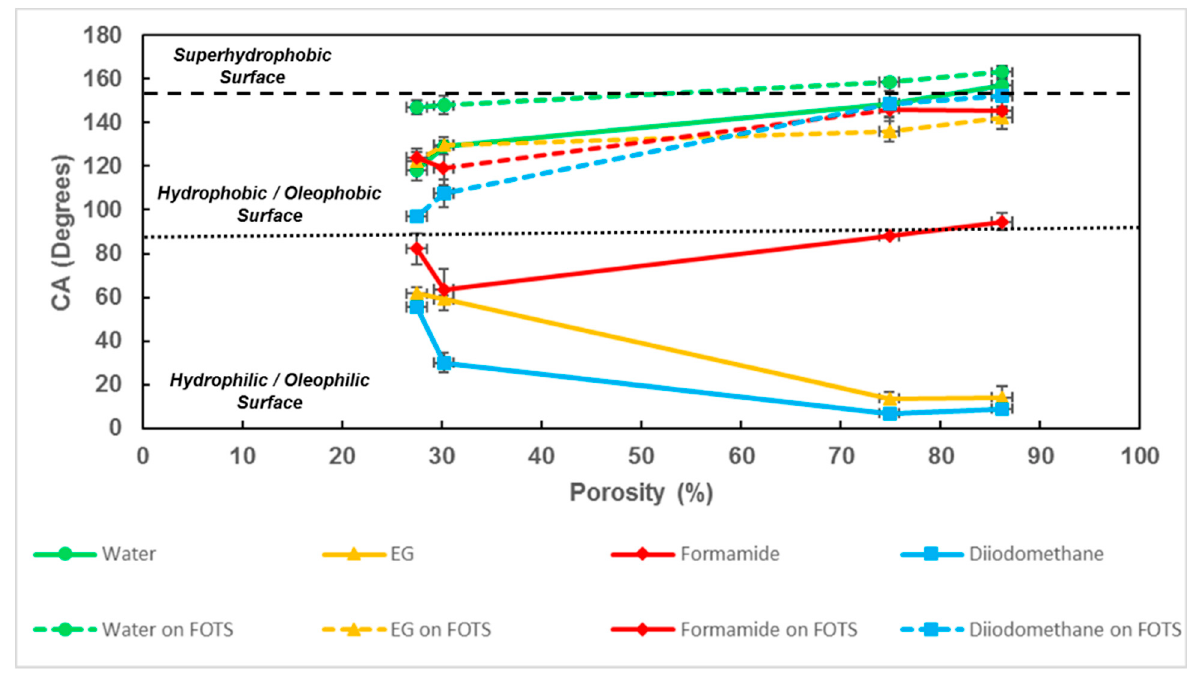
Figure 9. Comparison of CAs for different solvents at MacroPSi and MacroPSi-FOTS versus porosity.